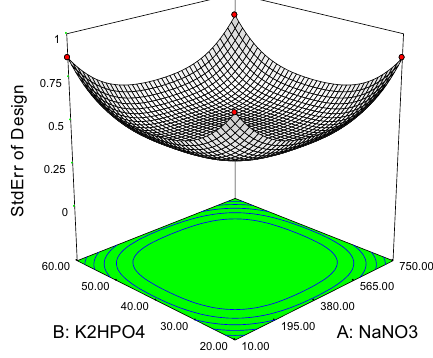
Fig. 3 Three-dimensional graph of standard error design of the model at NaNO 3 , K 2 HPO 4 and ferric ammonium